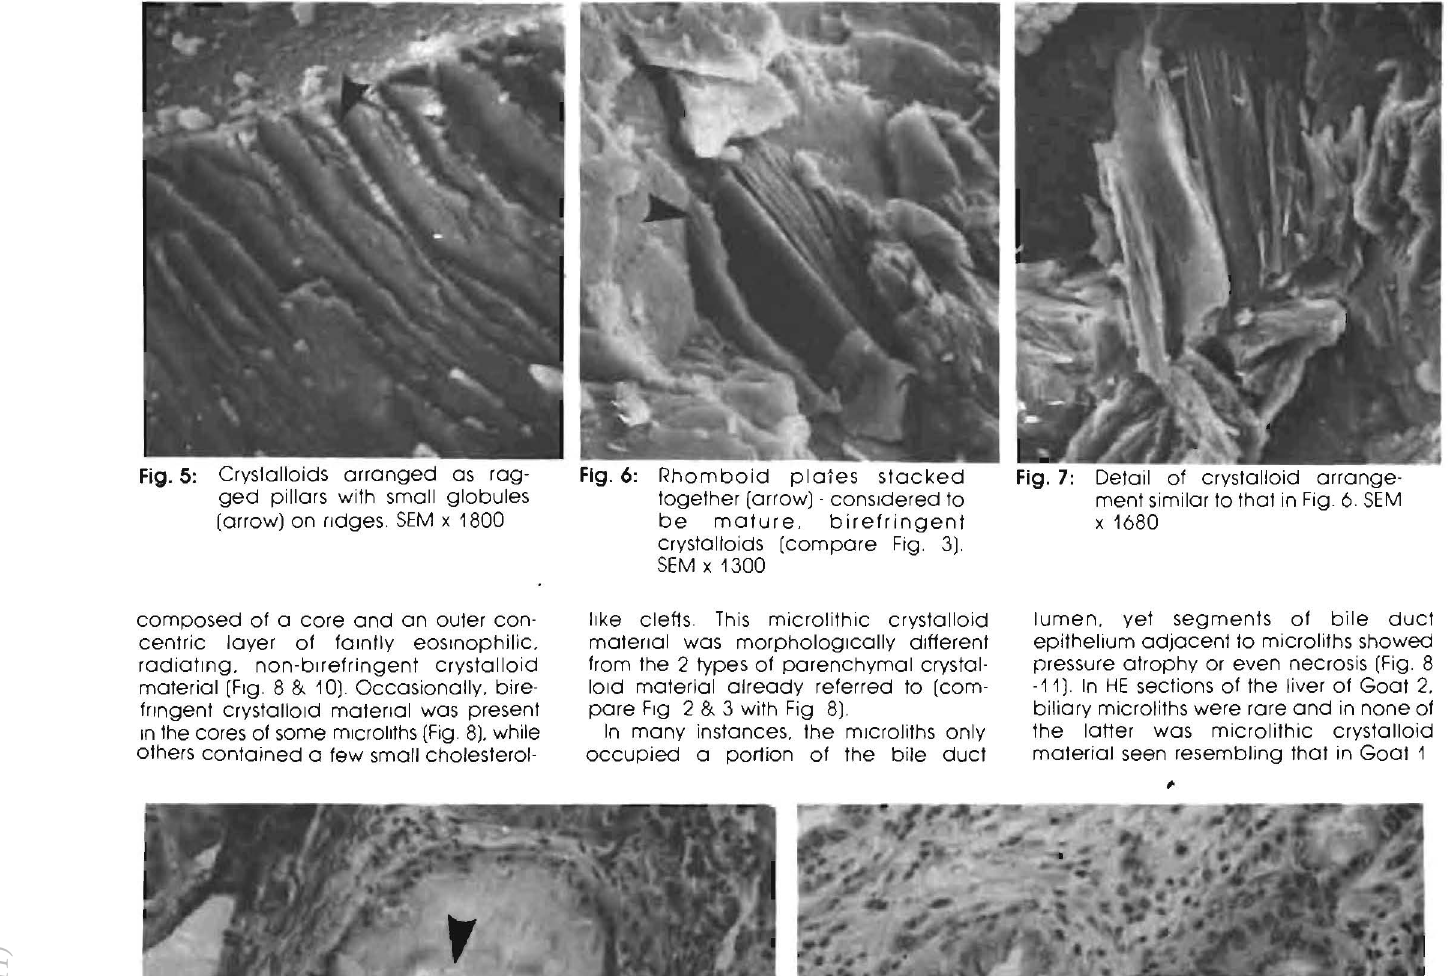
Fig. 7: Detail of crystalloid arrange· ment similar to that in Fig. 6. SEM x 1680